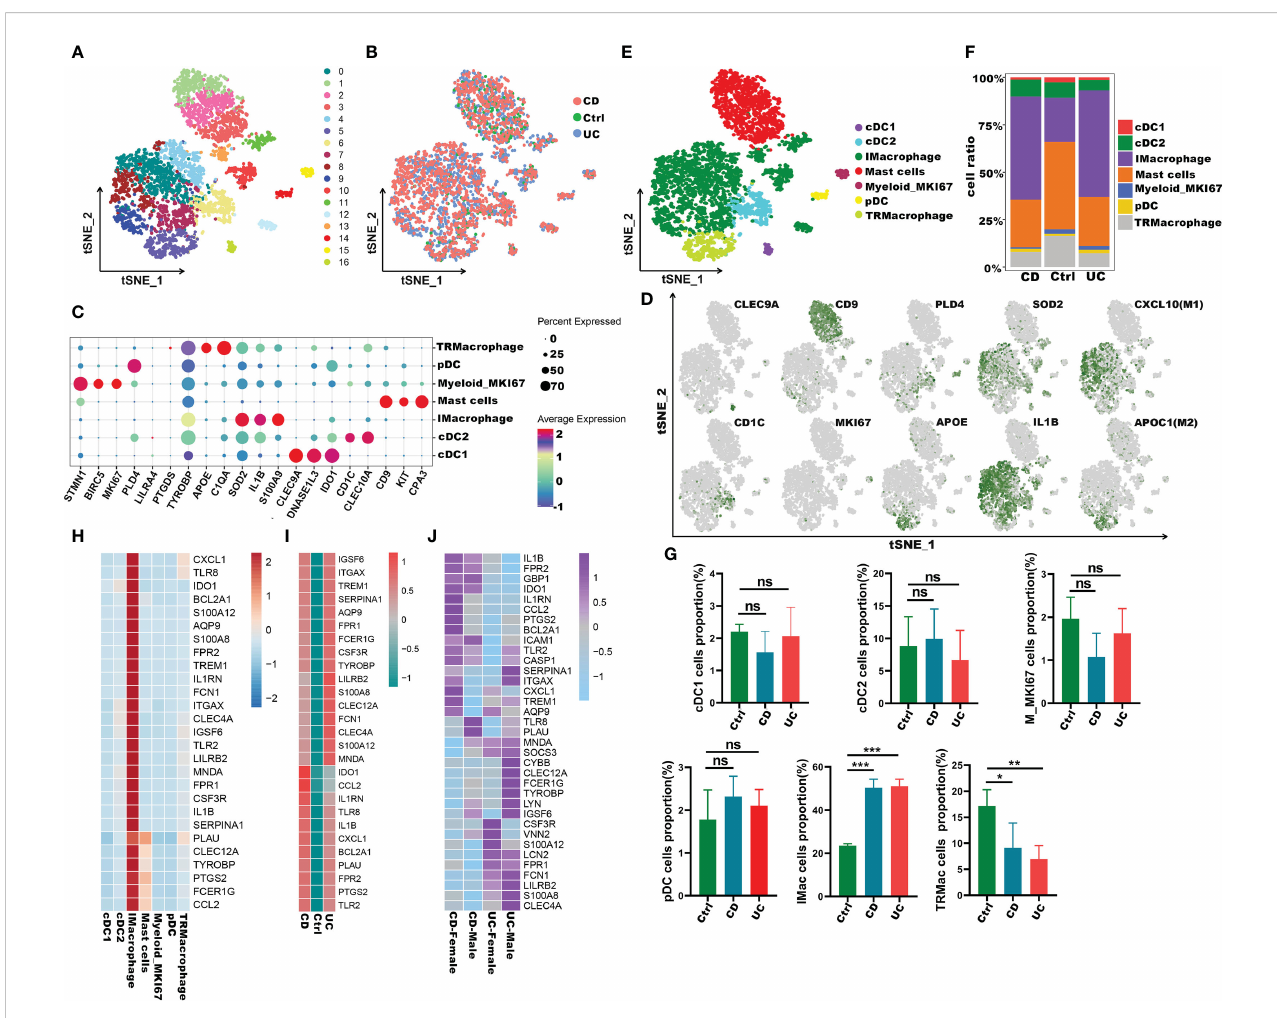
FIGURE 8 Immune characteristics of the IRGs at the single-cell resolution in myeloid cells of IBD. (A, B) t-SNE plot visualizing the clusters of myeloid cells from IBD and healthy controls; color denotes cluster origin (A) and samples origin (B) . (C) Dot plot depicting the gene expression level of signi fi cant marker genes in subgroups of myeloid cells. (D) t-SNE plot visualizing the expression of marker genes in different subgroups of myeloid cells. (E) t-SNE plot of subgroups of myeloid cells of IBD patients. (F) Proportion of subgroups of myeloid cells in IBD patients and health controls. (G) Bar plots showing the relative frequencies of different subgroups of myeloid cells in IBD and healthy controls. (H) Heatmap displaying the expression patterns of the IRGs in subgroups of myeloid cells. (I) Heatmap showing expression patterns of IRGs in IMacrophages between IBD and healthy individuals. (J) Heatmap showing expression patterns of IRGs in UC and CD patients with different genders *p < 0.05;**p < 0.01; ***p < 0.001; ns, not signi fi